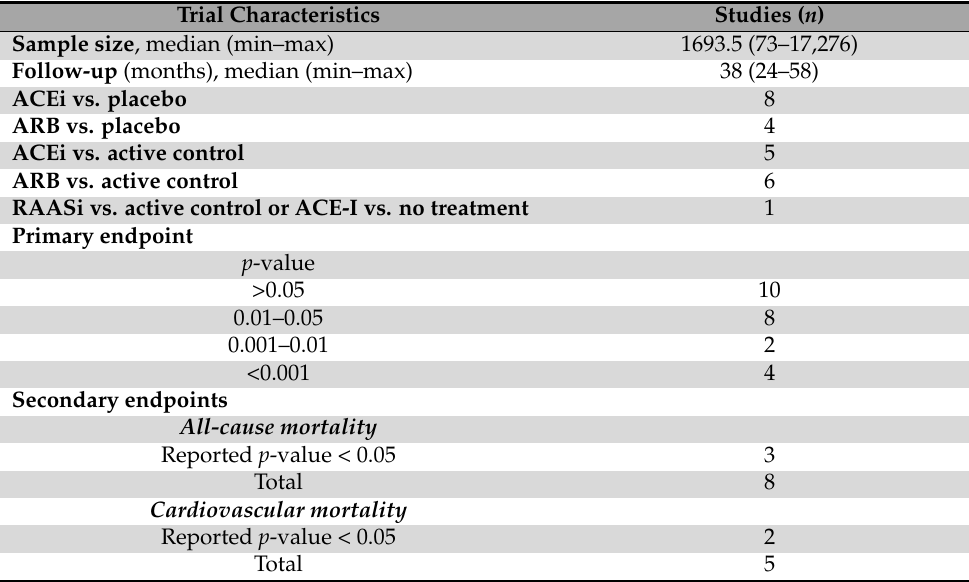
Table 1. Characteristics of included